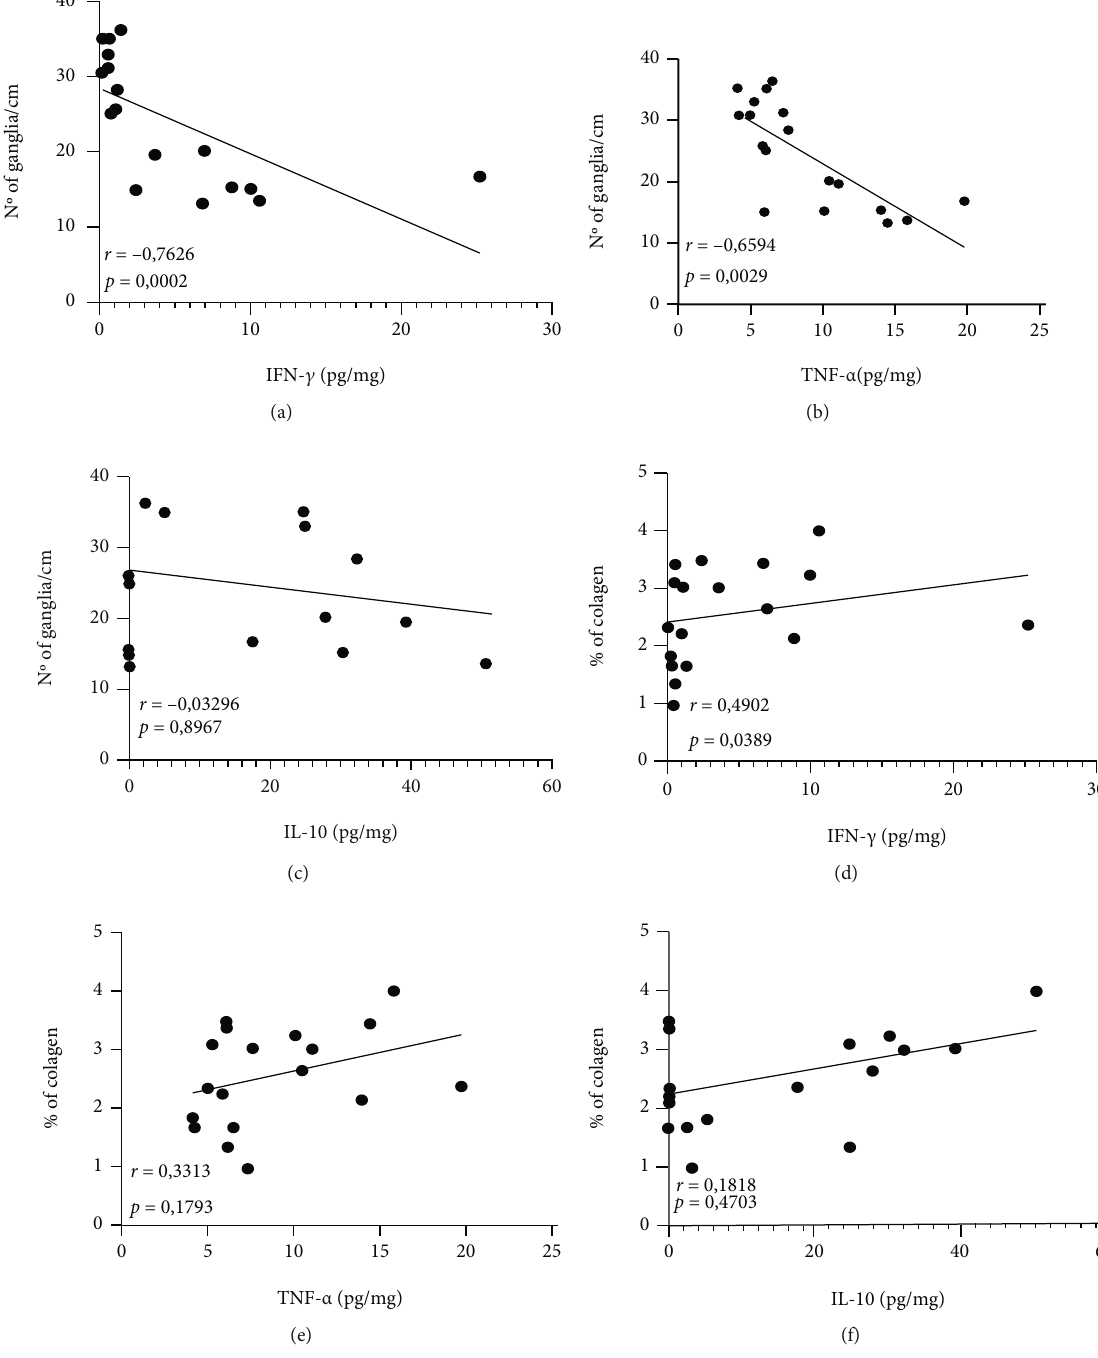
Figure 4: Correlations between the amount of nerve ganglia in the myenteric plexus with levels of intestinal (a) IFN- γ , (b) TNF- α , and (c) IL-10. Correlations between the percentage of intestinal collagen deposition with levels of intestinal (d) IFN- γ , (e) TNF- α , and (f) IL-10. Data obtained from uninfected animals in the acute phase and in the early chronic phase. Correlations were performed using the Spearman test. Signi fi cant statistical di ff erences at p < 0 : 05